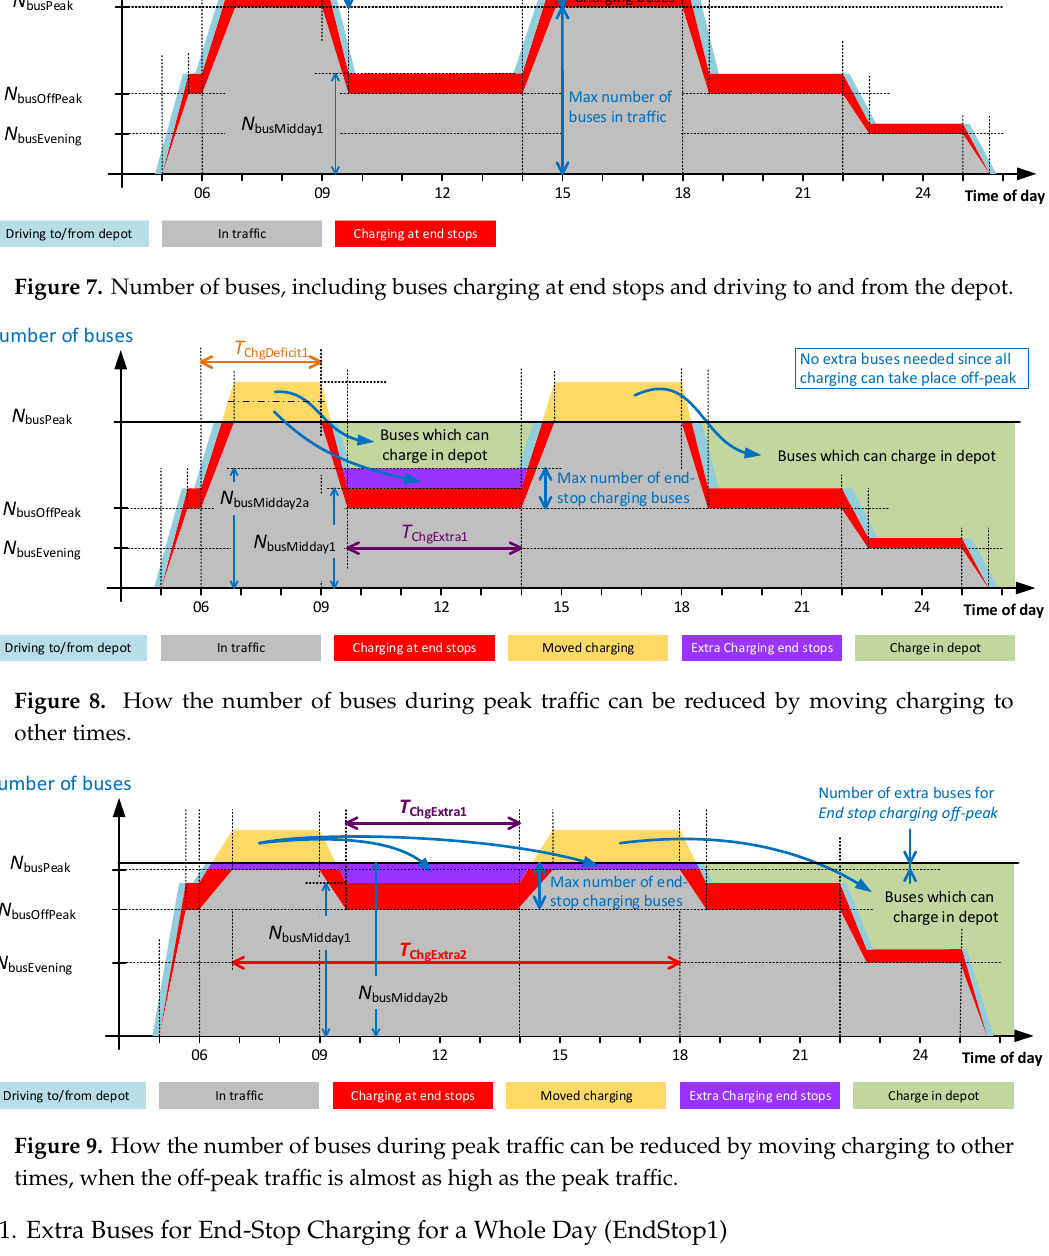
Figure 10. How the number of buses during peak traffic cannot be reduced if the off ‐ peak traffic is the same as the peak traffic.